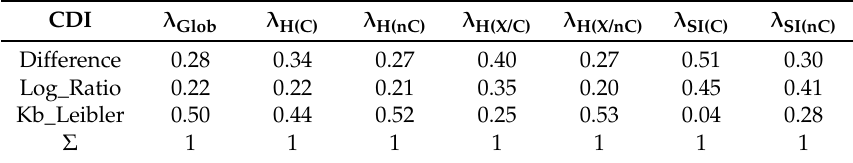
Table 4. DS2, Weights ( λ ) corresponding to CDI Information (metric) Measures.